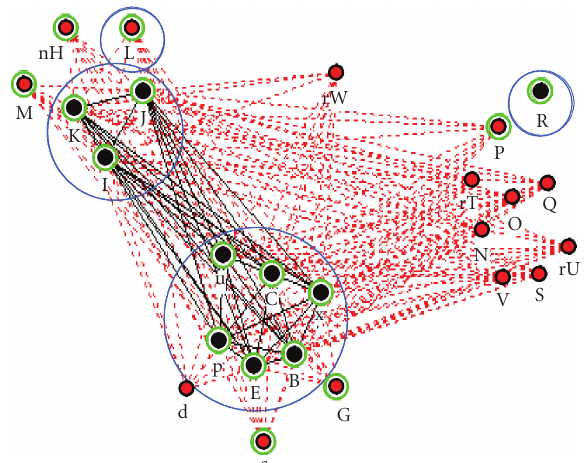
Figure 15: KeyGraph of cluster 2, where L and R (talk to mission NPCs) are among the keywords.